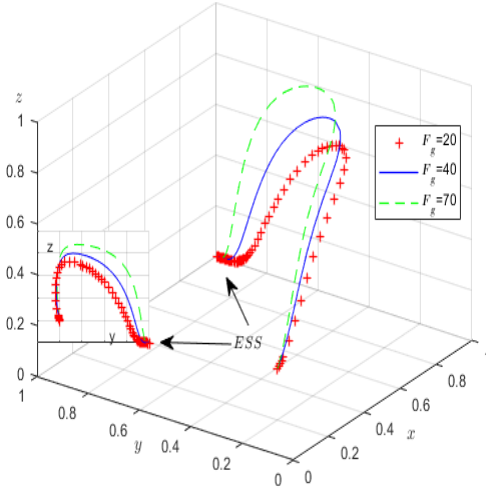
Figure 13. The influence of F g on evolutionary processes.